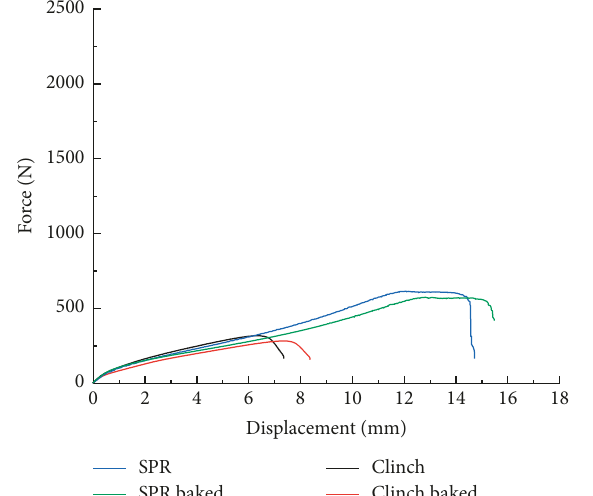
Figure 13: Comparison of coach-peel tests of SPR and clinched joints before and after the baking process at 0.083 × 10 − 3 m/s. Table 2: Test result summary (units: speed m/s, force (N), and energy (J)). Test